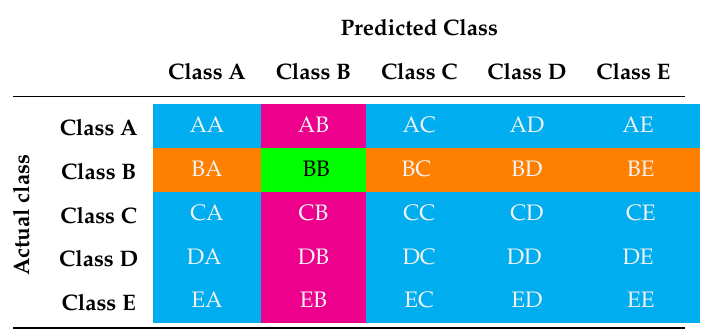
Table 4. Multi-class confusion matrix. In this case, the confusion matrix has five classes.